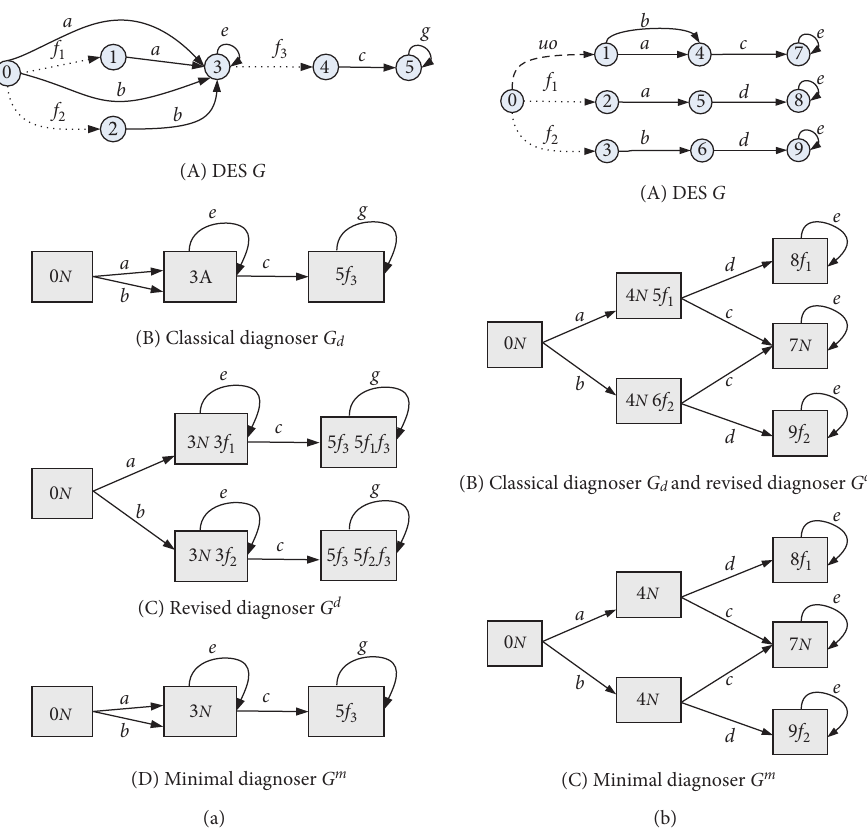
Figure 2: Two DESs and their minimal diagnosers: (a) the first DES and (b) the second